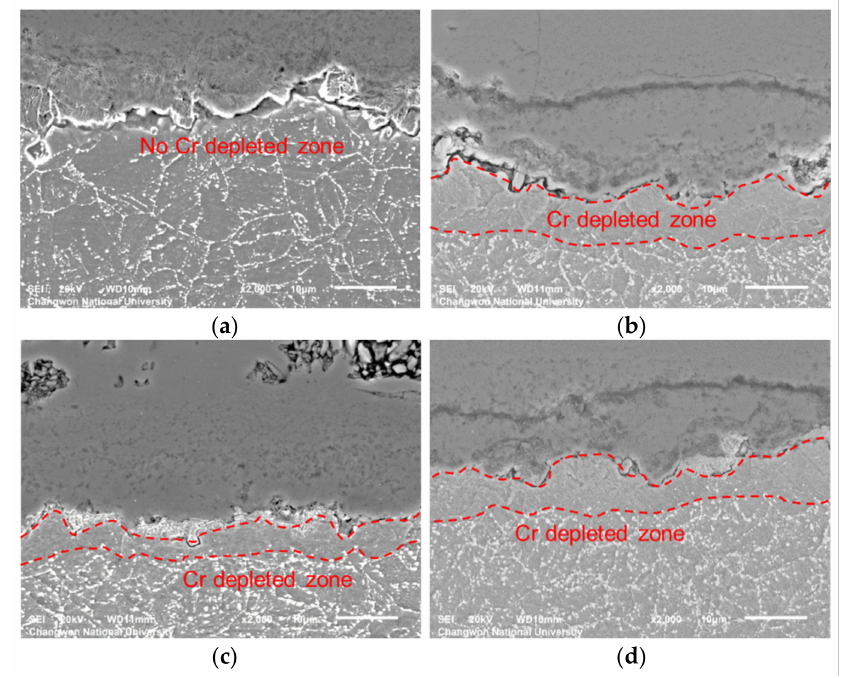
Figure 7. Cross-sectional SEM images of oxidation scale: ( a ) untreated 100 h, ( b ) untreated 600 h, ( c ) SP 100 h, and ( d ) SP 600